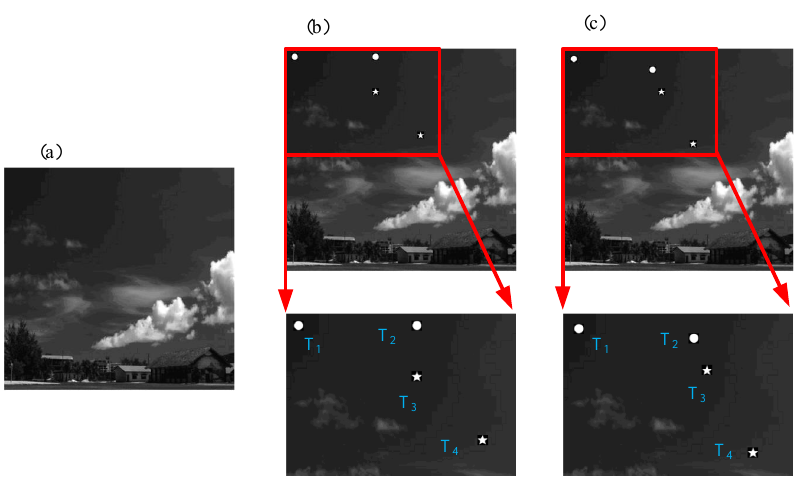
Figure 4. Simulation scenes: ( a ) a complex background, ( b ) a scene image at moment t 1 , and ( c ) a scene image at moment t 2 . There are four moving targets in the scene, denoted as T 1 , T 2 , T 3 , T 4 .